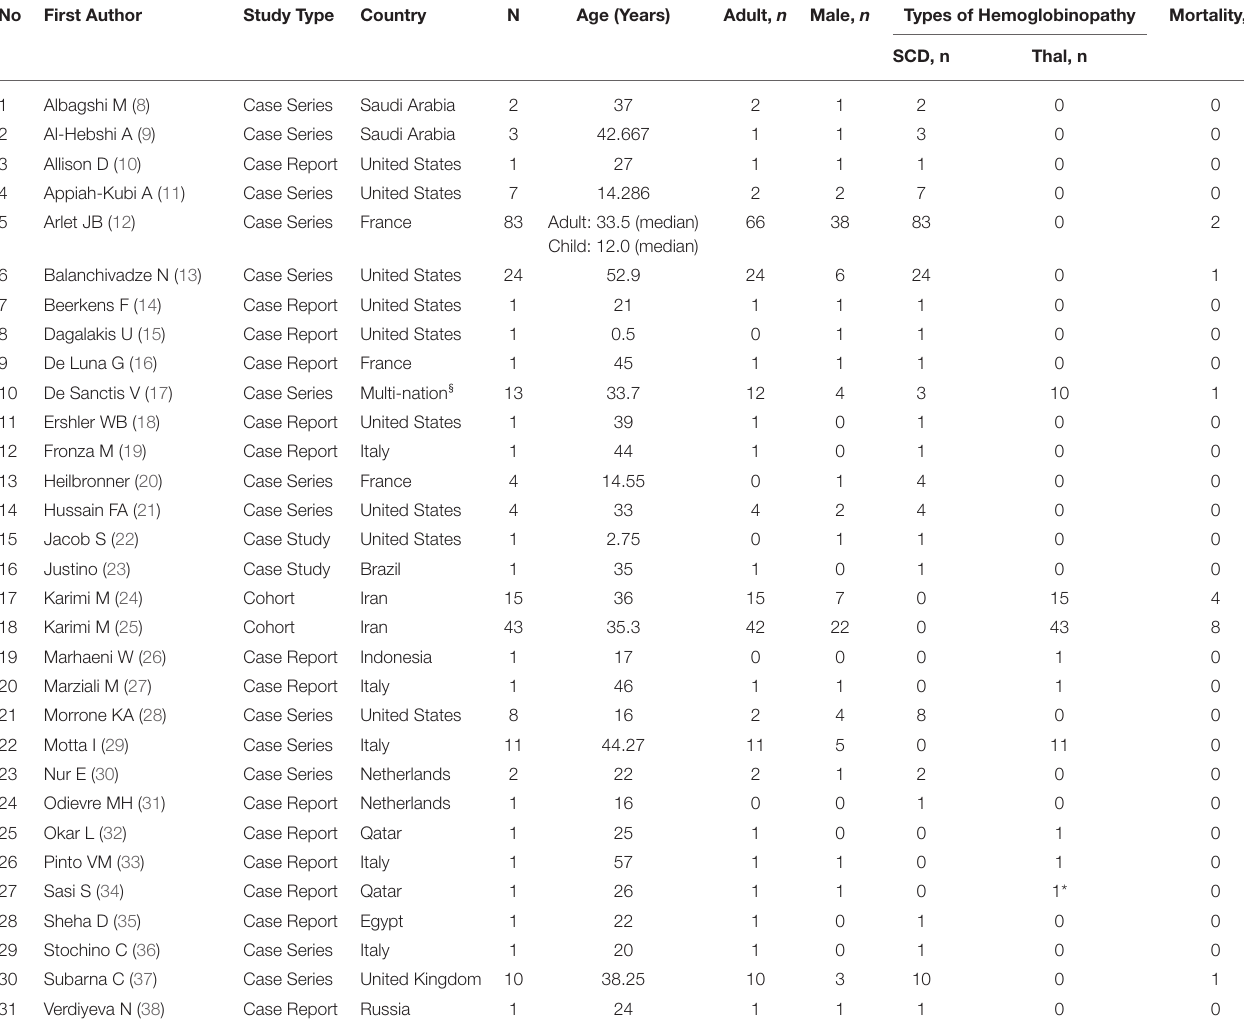
TABLE 1 | Characteristics of studies